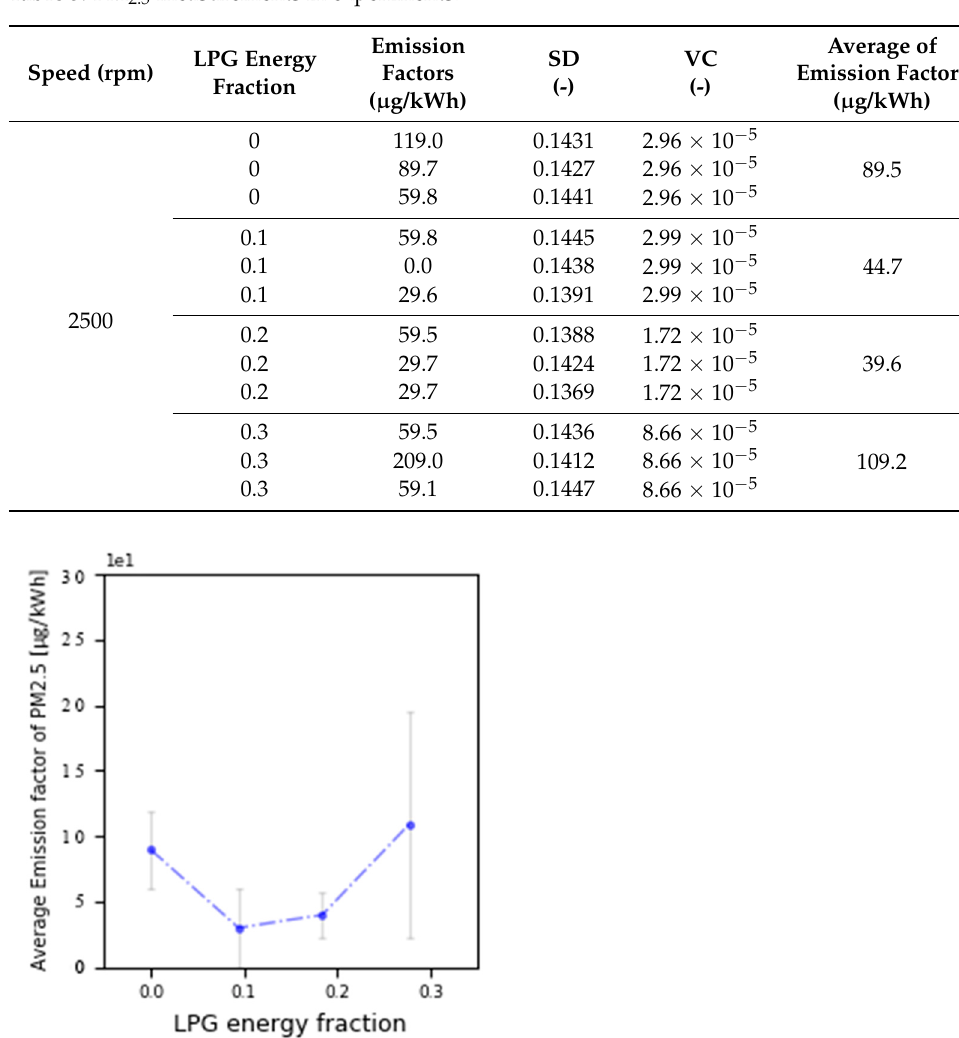
Table 5. PM 2.5 measurements in experiments.